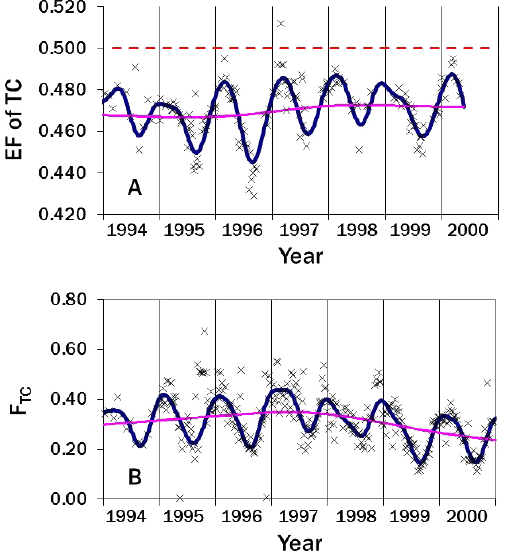
Figure 3. Seasonal (blue) and long-term (pink) trends in EFs of (a) TC and (b) CC, with experimental points marked (X), as in Fig. 2b. Figure 4. Seasonal (blue) and long-term (pink) trends in (a) EFs of TC and (b) F TC = TC /( TC + CC ) , with experimental points marked (X), as in Fig.